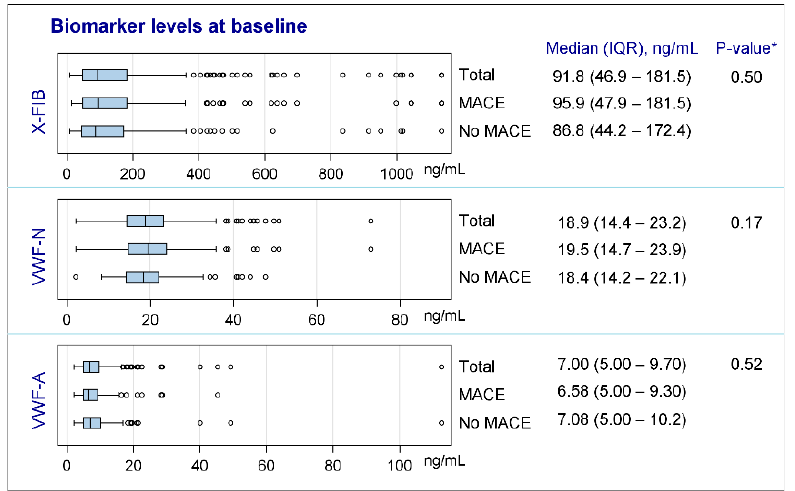
Figure 2. Characteristics of biomarkers at baseline. X-FIB: Cross-linked fibrin degeneration. VWF-